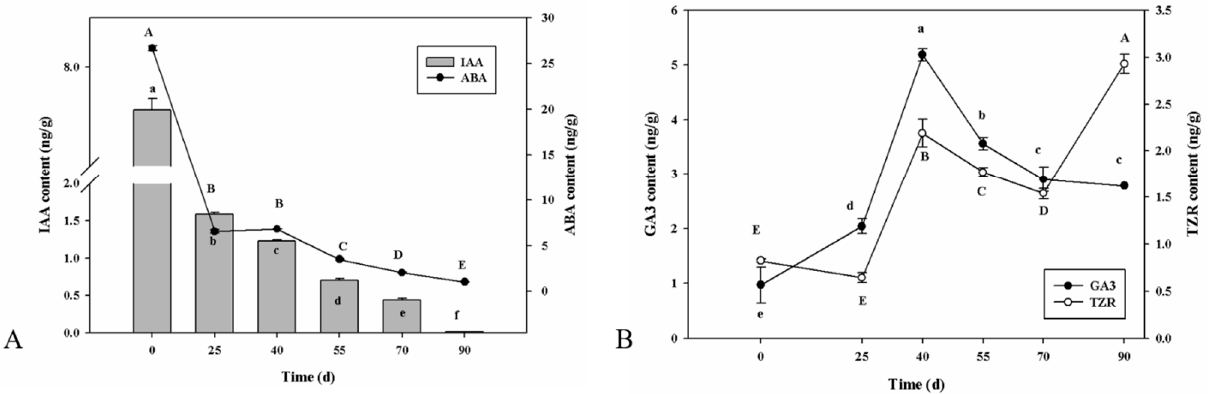
Figure 2. Phytohormonal dynamics content dynamics during seed germination and emergence pro- cess in P. cyrtonema Hua . Note: Different lowercase and capital letters indicate significant differences ( p < 0.05) among days of IAA, GA 3 , ABA, and TZR contents, respectively.